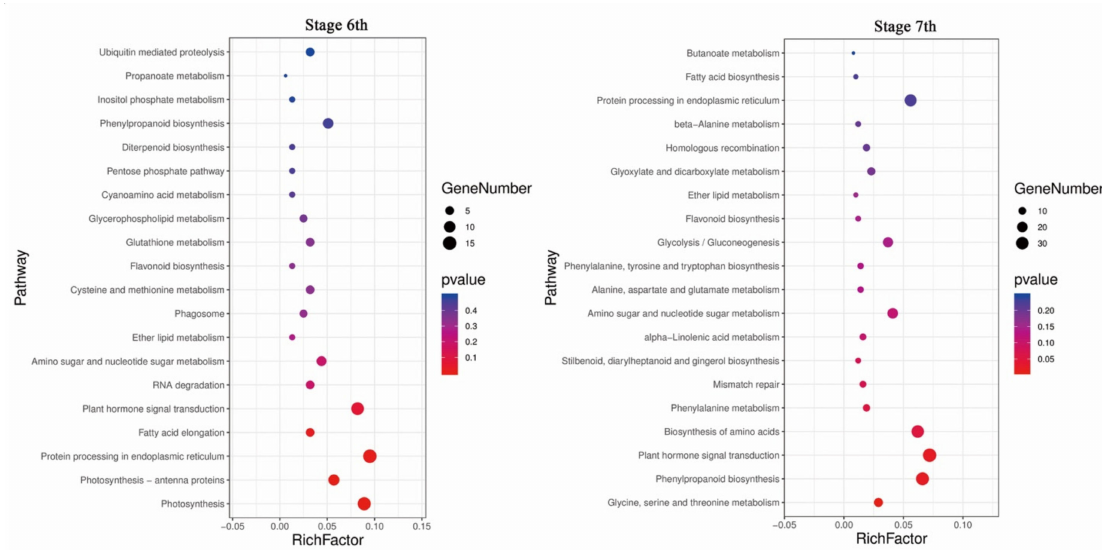
Figure 7. Kyoto Encyclopedia of Genes and Genomes (KEGG) enrichment analysis of DEGs in stages 6 and 7. The top 20 enriched pathways in stages 6 and 7 are shown. Each circle represents a KEGG pathway. The X-axis represents the enrichment factor, which compares the ratio of genes annotated to a pathway among the DEGs to the ratio of genes annotated to that pathway among all genes, and the Y-axis represents the pathway